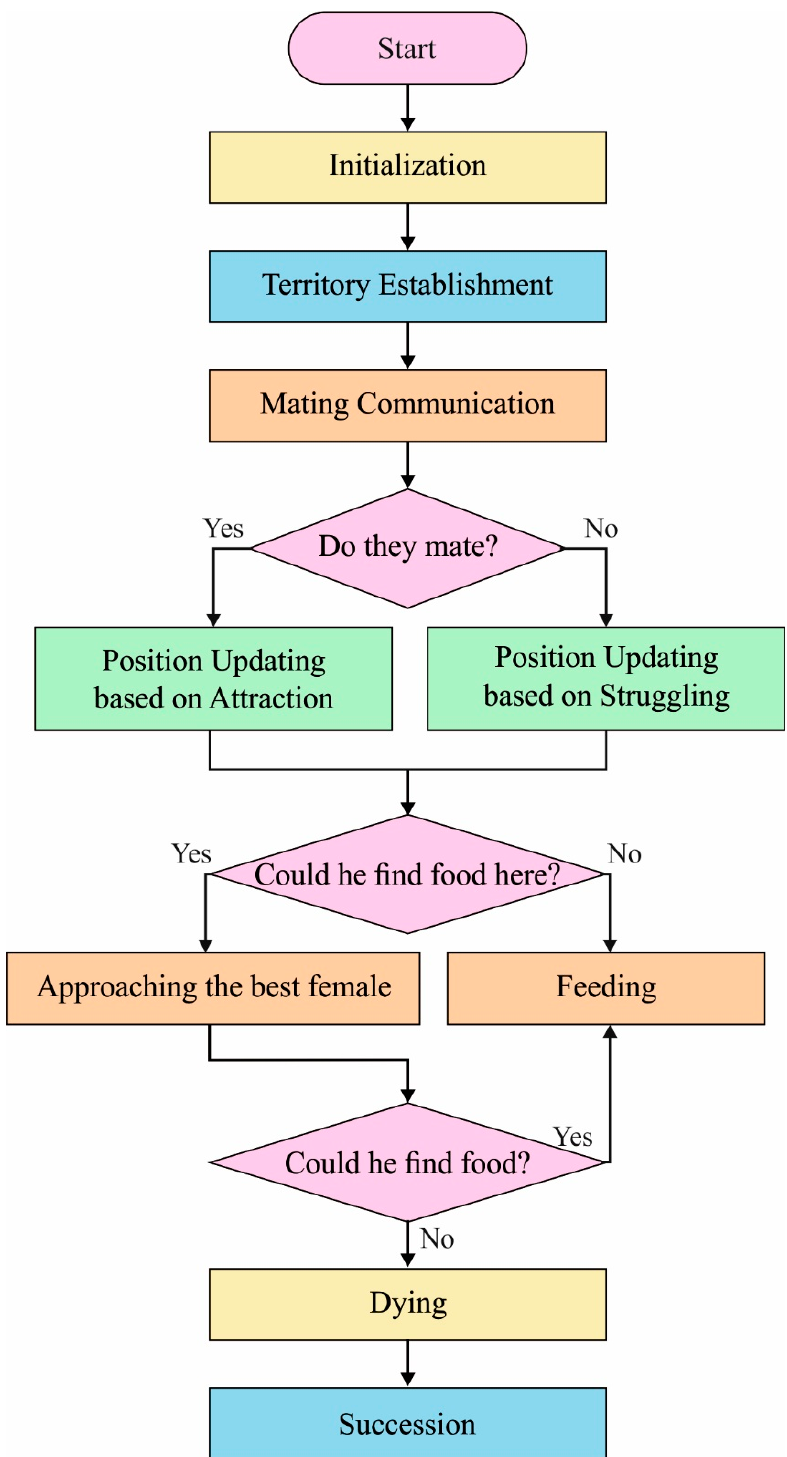
Figure 2. Flowchart of WSA.